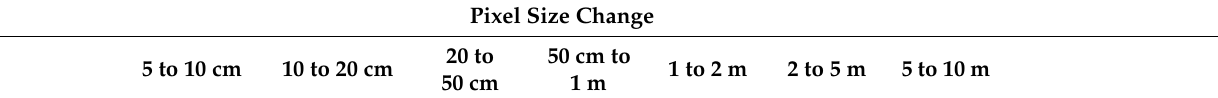
Table 1. Changes in the slope gradient and the slope length with the variation of DEM